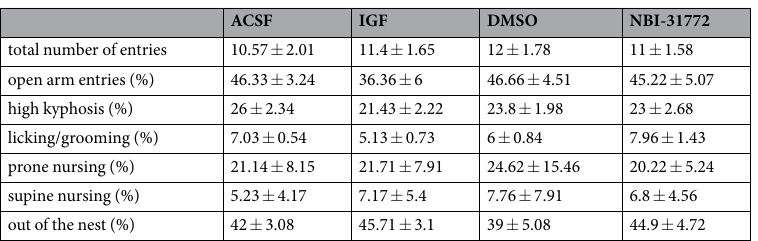
Table 2. Antagonism of IGFBP-3 does not change undisturbed maternal behaviour and elevated plus-maze test performance of rat dams. The ratio of 5 examined elements of maternal behaviours is shown in the table. In the elevated plus maze test, unchanged total number of entries suggest unaltered motility of the animals while the lack of significantly changed open arm entry frequency suggest unaltered anxiety-like